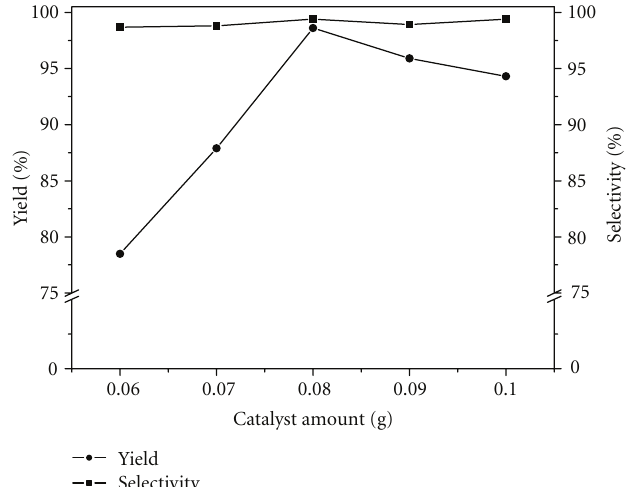
F 7: Effect of the amount of catalyst on the cyclic carbonate synthesis. Reaction conditions: ECH 3mL, PS-QPS-1, 5MPa